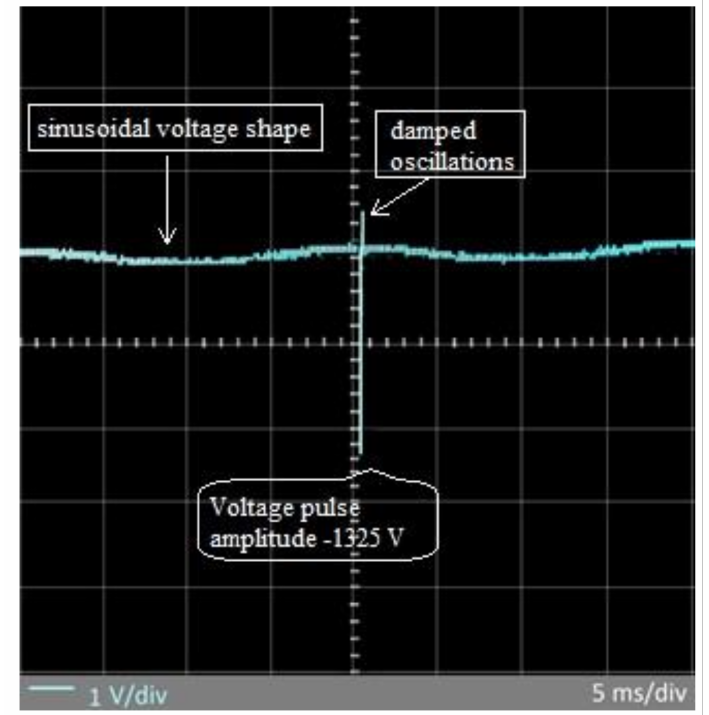
Figure 18. Voltage waveform in a photovoltaic system disturbed by a 1.2/50 µ s voltage surge with negative